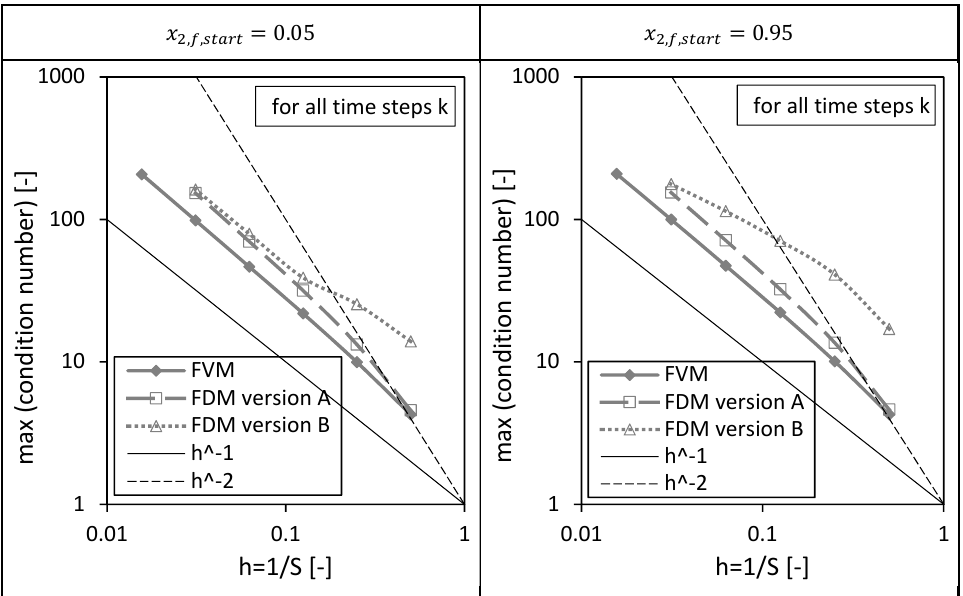
Figure 11. Maximum of the condition numbers of 𝐴 (cid:3004)(cid:3007)(cid:3020)(cid:3038) and 𝐴 (cid:3007)(cid:3005)(cid:3014)(cid:3038) (version A and B) corresponding to the FVM, FDM version A and B using x (cid:2870),(cid:2916)(cid:2929)(cid:2930)(cid:2911)(cid:2928)(cid:2930) = 0.05 (left panel) and x (cid:2870),(cid:2916)(cid:2929)(cid:2930)(cid:2911)(cid:2928)(cid:2930) = 0.95 (right panel) depending on the reciprocal of the number of nodes S. Calculation settings: N = 26, S REF = 64, Δ t = 0.05 s (for FVM, FDM version A and B).